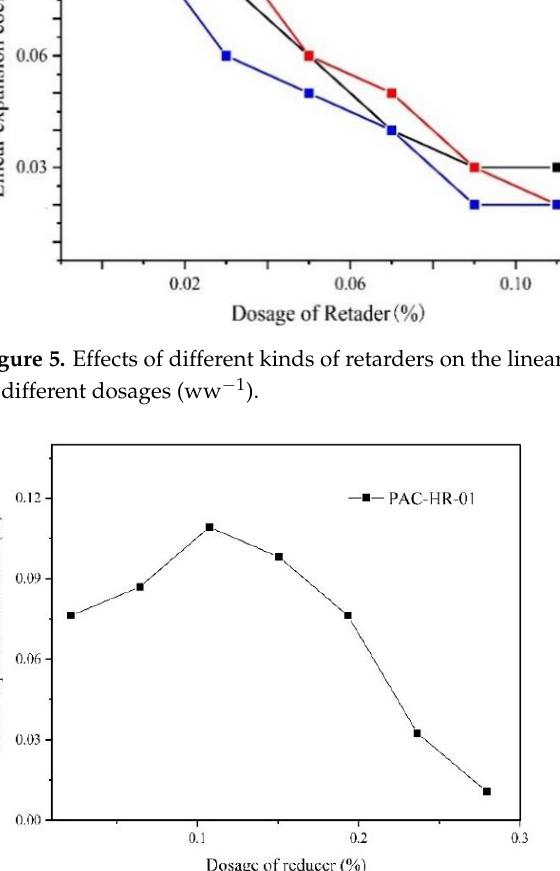
Figure 6. The effect of PAC-HR-01 on the linear expansion coefficient of dental gypsum at different dosages (ww −1 ).